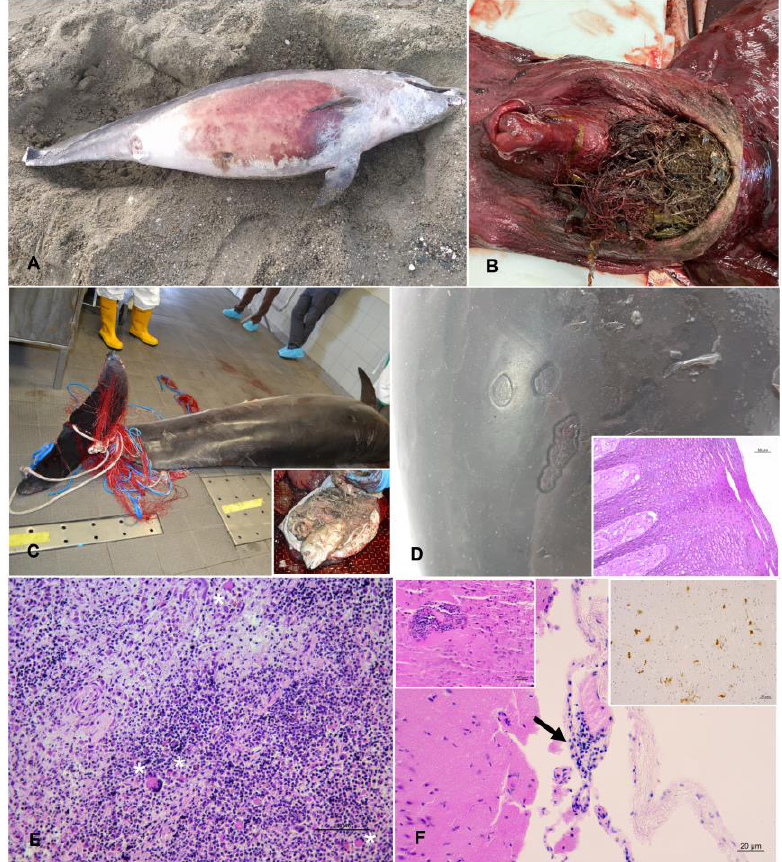
Figure 2. Macroscopic and microscopic images of some of the animals under study. ( A ) (Case 8) Amputation of the caudal fin, as a consequence of suspected fishery interaction (bycatch with not determined fishing gear). ( B ) (Case 10) Marine litter (fishing line agglomerate) in the esophagus. ( C ) (Case 5) Rope and nets at the tail. Lower right inset recent meal outcomes. ( D ) (Case 6) Tattoo skin lesions. Lower right inset multifocal areas of severe cytoplasmic vacuolation of the keratinocytes in the Stratum spinosum , with the formation of intraepithelial vesicles. Scale bar = 50 μm. ( E ) Prescapular lymph node (Case 4). Severe lymphoid depletion with several multinucleated giant cells (asterisks). Hematoxylin & Eosin (HE). Scale bar = 100 μm. ( F ) Occipital cortex (Case 11). Focal non suppurative meningitis (arrow). Upper left inset: frontal cortex (Case 11). Perivascular cuffing characterized by lymphocytes and plasma cells. HE. Scale bar = 20 μm. Upper right inset: Parietal cortex (Case 4). Positive labelling of endothelial and neuronal cells. Scale bar = 20 μm. IHC for CeMV.